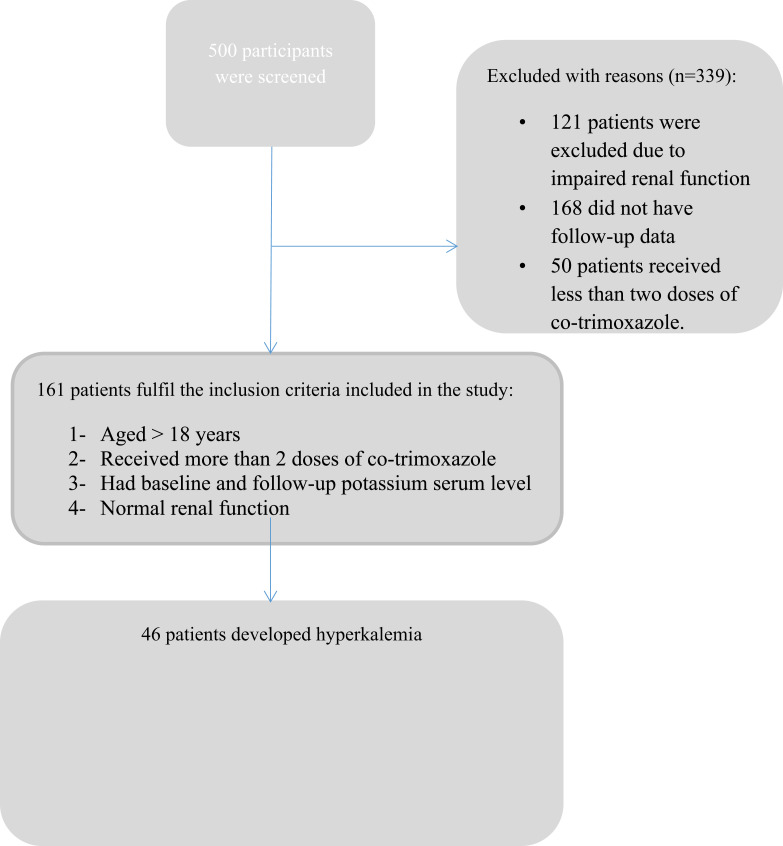
A flow chart of the screening process.